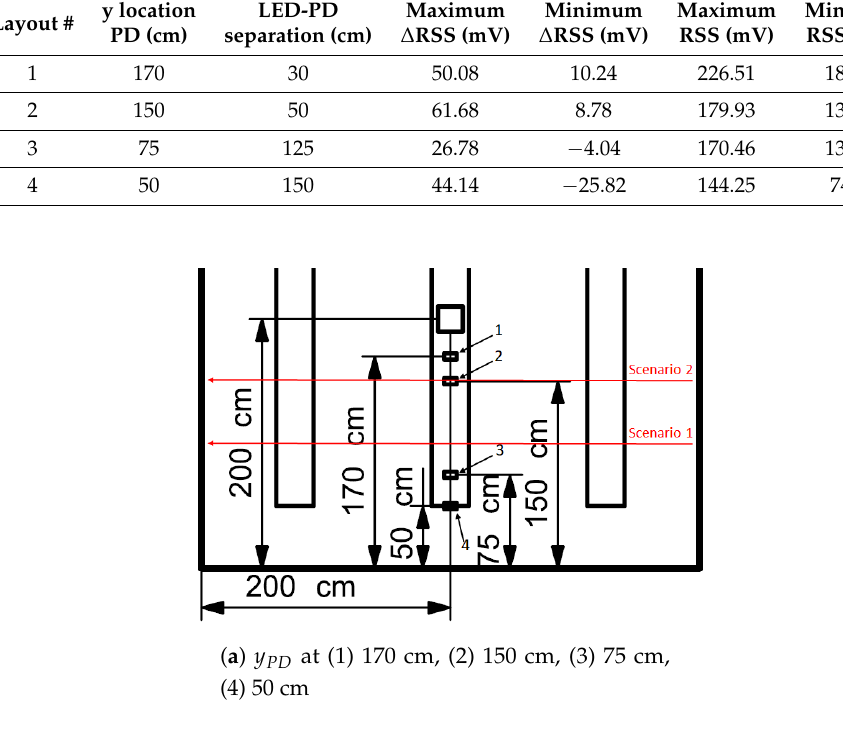
Table 2. PD locations for the different layouts and the maxima and minima ( ∆ )RSS values. Layout